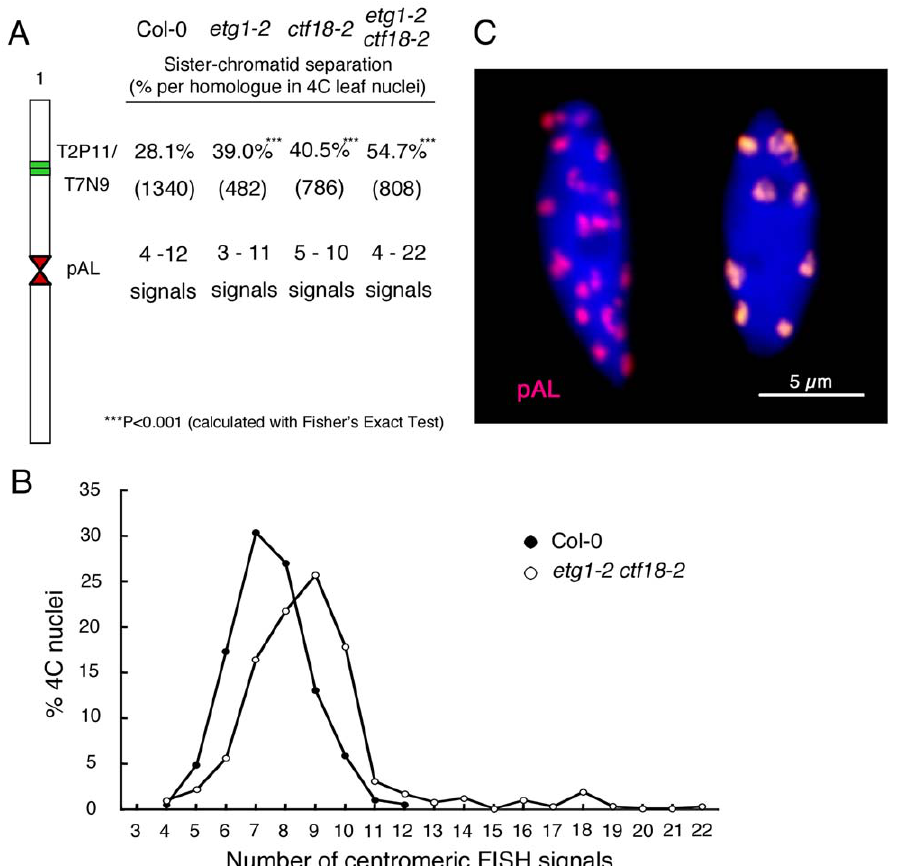
Figure 5. Synergistic effect of etg1 and ctf18 on sister chromatid cohesion in 4C leaf nuclei. (A) Percentage of positional separation frequencies (number of investigated nuclei in parentheses) analyzed in wild-type (Col-0) and etg1-2 ctf18-2 mutant plants after FISH with the labeled T2P11 BAC from chromosome 1. The FISH probe pAL detected the centromeric 178-bp repeats. More than the expected 20 signals from separated sister centromeres in 4C nuclei might be caused by signal splitting due to pAL repeat elongation along the centromeres. (B) Frequency of centromeric signals in the etg1 ctf18 double mutant compared to wild-type nuclei. (C) Sister centromere separation in an etg1 ctf18 nucleus (left) compared to aligned sister centromeres in a wild-type nucleus (right). Due to occasional centromere fusion, the average signal number in the wild- type is 8 instead of 10.